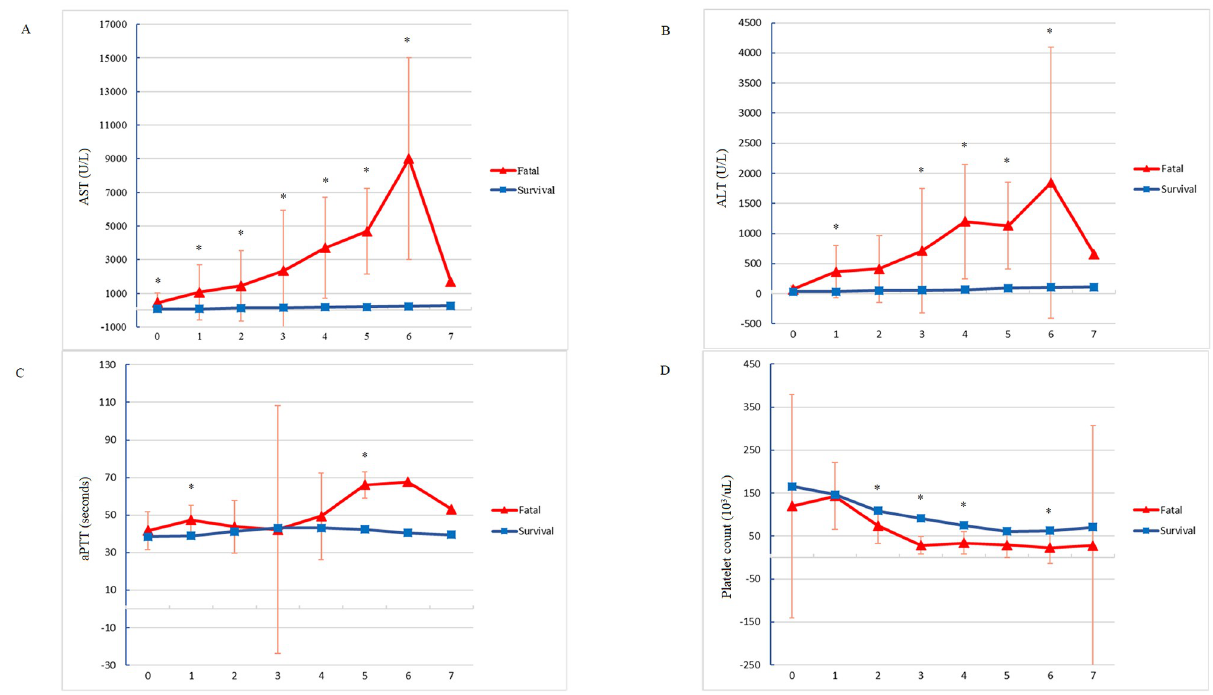
Fig 1. Trend variations in serum aspartate transaminase (AST) (Panel A), alanine transaminase (ALT) (Panel B), activated partial thromboplastin time (aPTT) (Panel C), and platelet count (Panel D) of the fatal and surviving patients with dengue fever within 8 days of illness